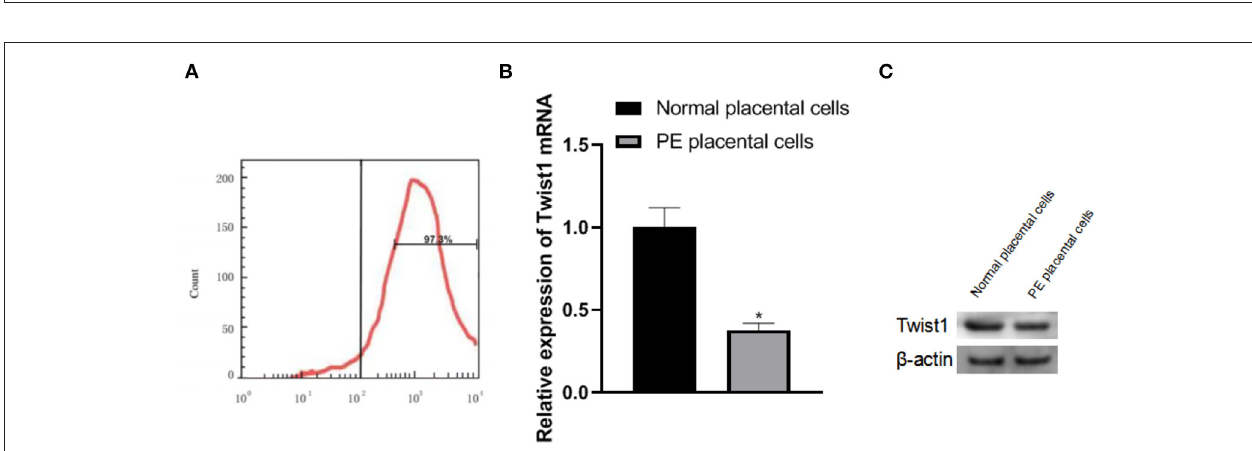
FIGURE 1 | The expression of Twist1 mRNA and protein in different placental tissues. (A,B) The expression of Twist1 mRNA and protein; Compared with Normal pregnancy term placenta, * p < 0.05; compared with Chorionic Abortion in Early Pregnancy, # p < 0.05.